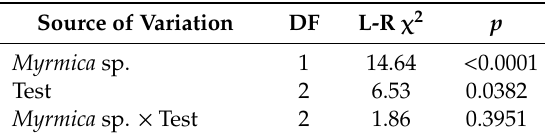
Table 3. Results of analysis of survival over the 20 days of the tests plus comparison with the survival in the nurse colonies over the same period, using a generalized linear model with binomial errors. The replication unit for this analysis is the test or nurse colony (n = 60). The significance of changes in deviance associated with di ff erent terms in the model was assessed using Likelihood-ratio (L-R) χ 2 tests. Potential sources of variation in survivorship were: Myrmica sp.—The introduced Myrmica species for the test colonies, and the nurse species for the nurse colonies, either M. scabrinodis or M. sabuleti . The Test (“Vacant possession”, “Takeover”, or nurse colony), and their interaction. Source of Variation DF L-R χ 2 Myrmica